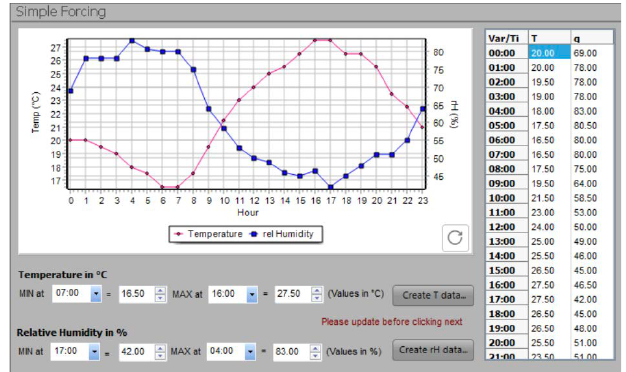
Figure 4. Screenshot of the meteorological input data for the ENVI-met ® simulation in an hourly profile using simple forcing method for the Elief case study.